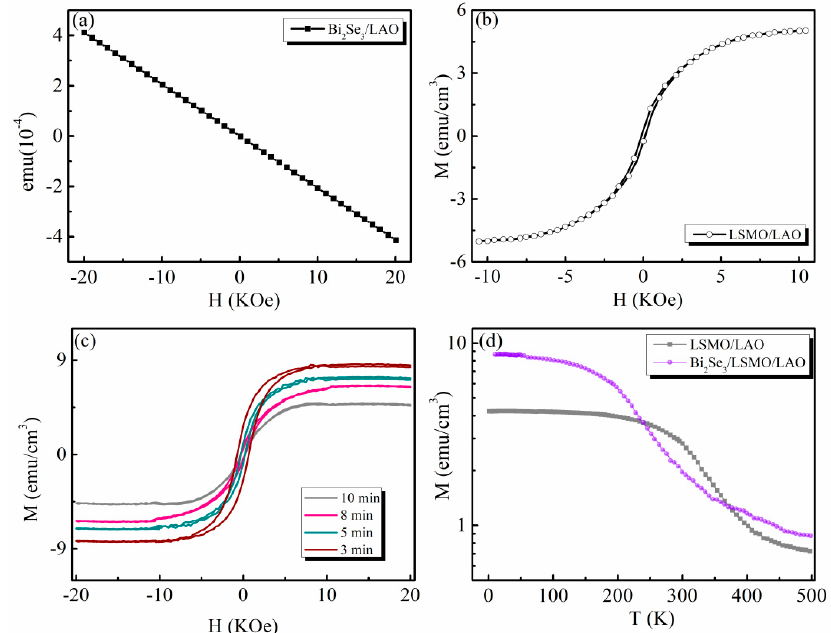
Figure 8. Hysteresis curves measured at 10 K with an in-plane applied field: ( a ) the Bi 2 Se 3 /LAO films, ( b ) the LSMO/LAO films measured, ( c ) the Bi 2 Se 3 /LSMO/LAO films. ( d ) Magnetization versus temperature of Bi 2 Se 3 film on LSMO/LAO measured during field cooling with 1 kOe.